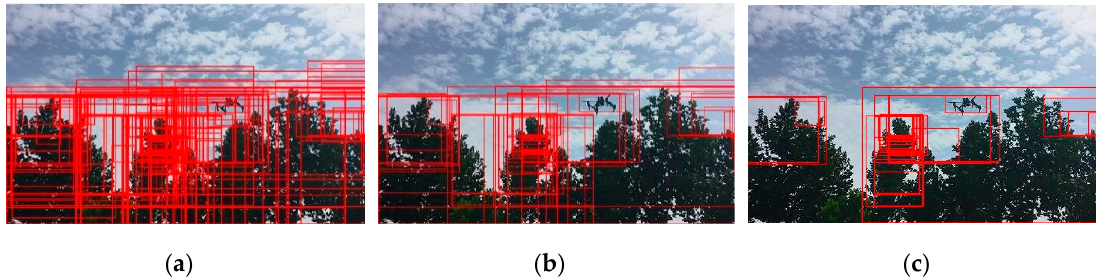
Figure 6. Candidate regions: ( a ) max number of boxes = 200; ( b ) max number of boxes = 100; ( c ) max number of boxes = 50.